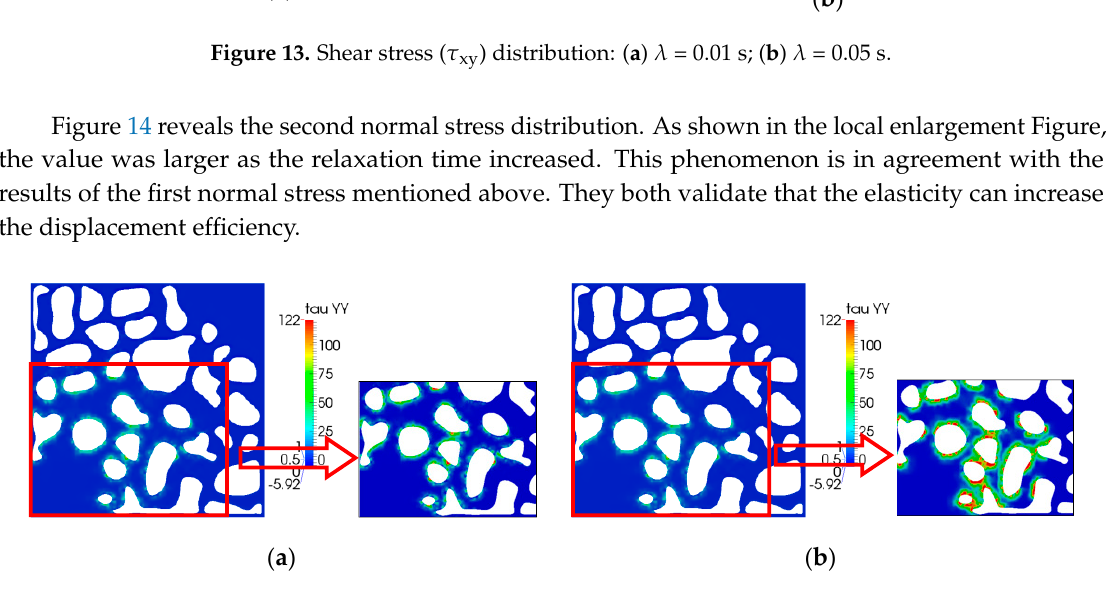
Figure 14. Shear stress ( τ xy ) distribution: ( a ) λ = 0.01 s; ( b ) λ = 0.05 s.